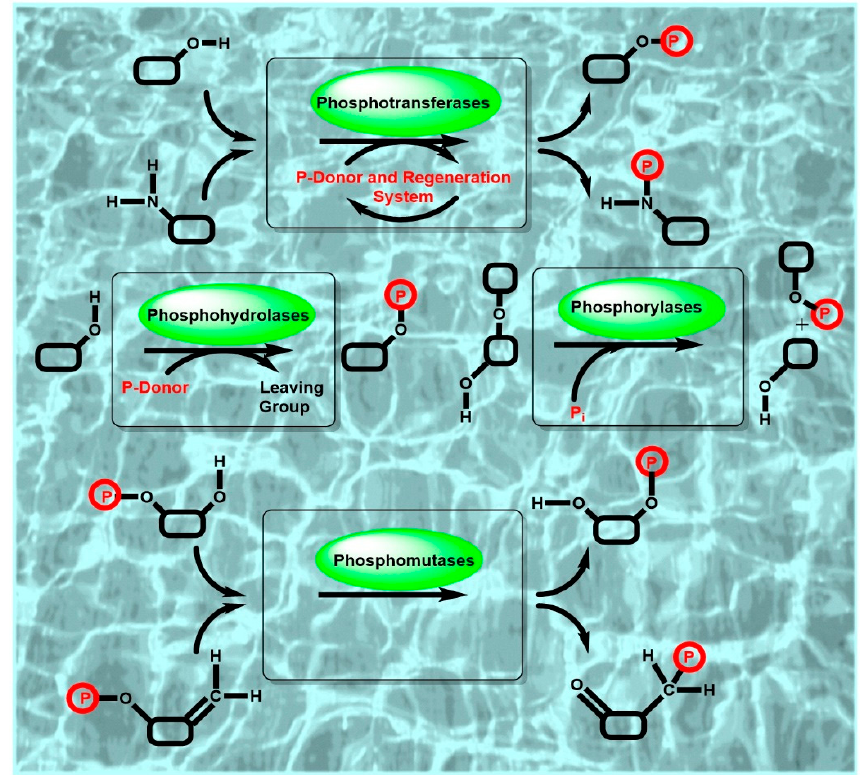
Figure 1. Schematic representation of key classes of phosphorylation biocatalysts and the involved reactions.